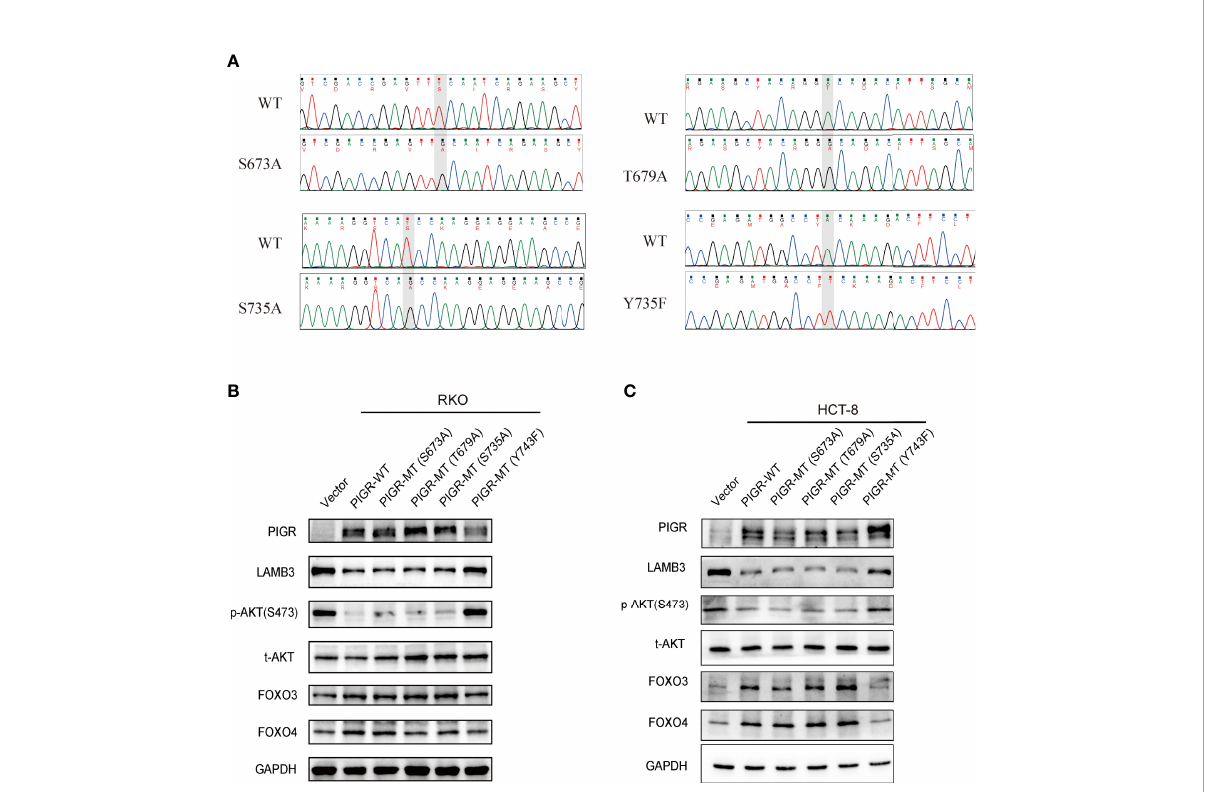
FIGURE 5 T743 of PIGR is essential for its anti-tumor effects (A) Successful point mutations of PIGR were con fi rmed by Sanger sequencing. (B, C) Western blot showed altered protein levels of AKT-FOXO3/4 axis in empty vector (Lane 1), PIGR wild-type (Lane 2), PIGR-S673A (Lane 3), PIGR-T679A (Lane 4), PIGR-S735A (Lane 5) and PIGR-Y743F (Lane 6) in RKO and HCT-8